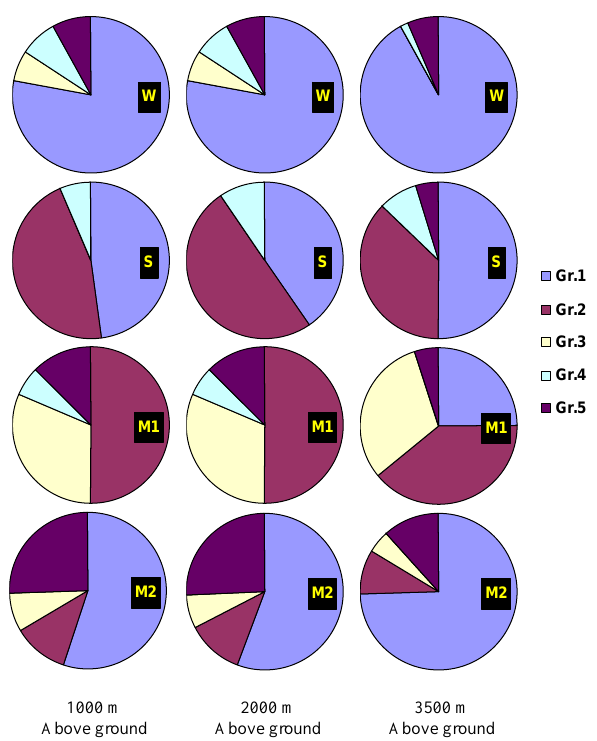
Figure 10 : Percent contribution of the different source regions to the air mass flow at Fig. 10. Percent contribution of the different source regions to the Dibrugarh at 1000, 2000 and 3500 m above ground. air mass flow at Dibrugarh at 1000, 2000 and 3500m above ground